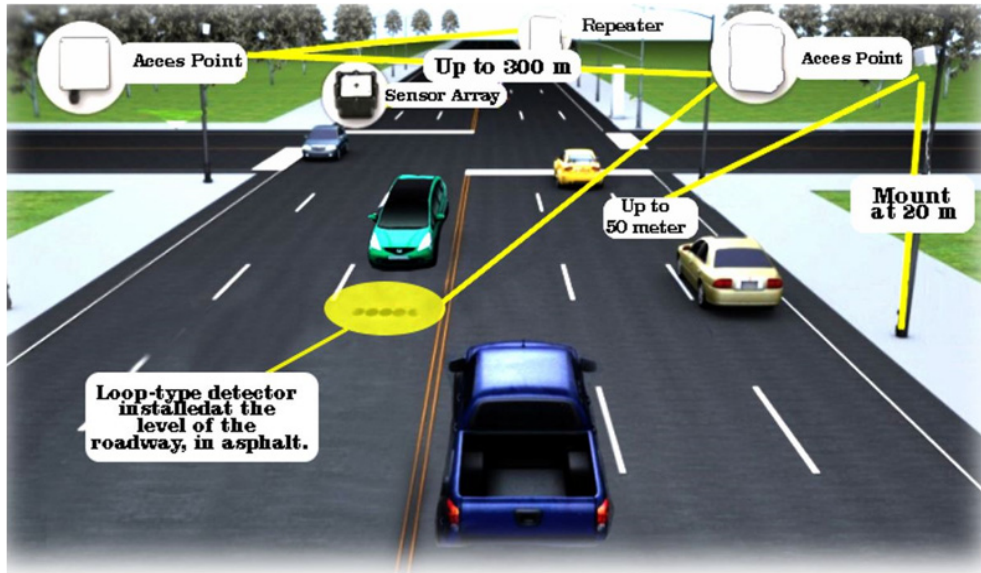
Figure 2. Representative diagram of a loop detector prototype.